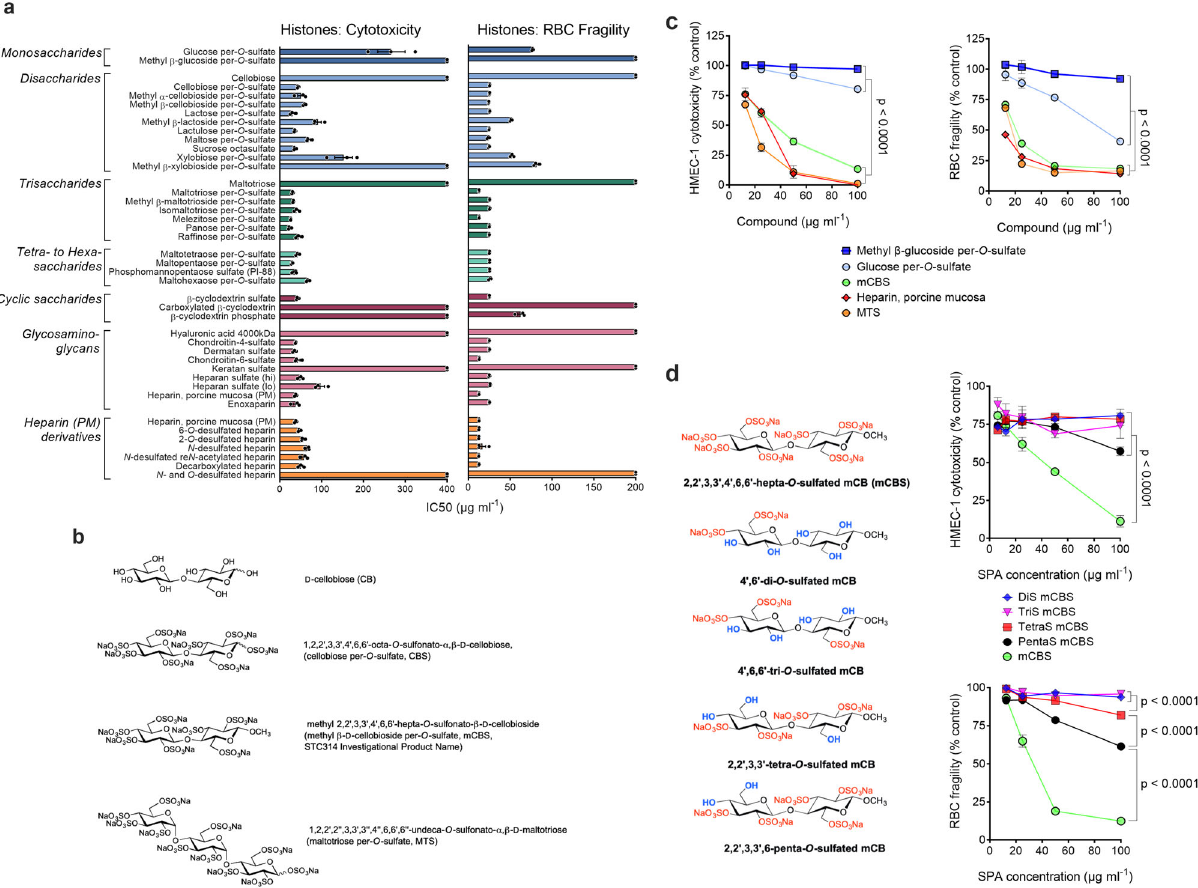
Fig. 1 Polyanions inhibit histone-mediated endothelial cell cytotoxicity and RBC fragility with minimal structural requirements for the activity identi fi ed. a Human endothelial cells (HMEC-1) (left panel) or red blood cells (RBCs) (right panel) were incubated (1 h, 37 °C) with histones (400 μ g ml − 1 ) in the presence of different polyanion concentrations and IC 50 values (mean of three separate determinations ± s.e.m.) for HMEC-1 cytotoxicity or RBC fragility determined. Heparan sulfate (lo) and (hi) represent low and highly sulfated heparan sulfate. b Chemical structures of compounds selected for future study. c Sulfated disaccharide mCBS has minimal structural requirements to approximate inhibitory effect of heparin on histone-mediated cytotoxicity and RBC fragility, the monosaccharides, methyl β -glucoside per- O -sulfate and glucose per- O -sulfate having little or no activity. d Effect of the level of sulfation of mCB (di-, tri-, tetra-, and penta- O- sulfated) on its ability to be an effective inhibitor of histone-mediated cytotoxicity and RBC fragility compared to fully sulfated (hepta- O- sulfated) mCBS. Data are presented as mean ± s.e.m. ( n = 3) and analyzed by two-way ANOVA with Tukey ’ s correction for multiple comparisons. Source data are provided as a Source Data